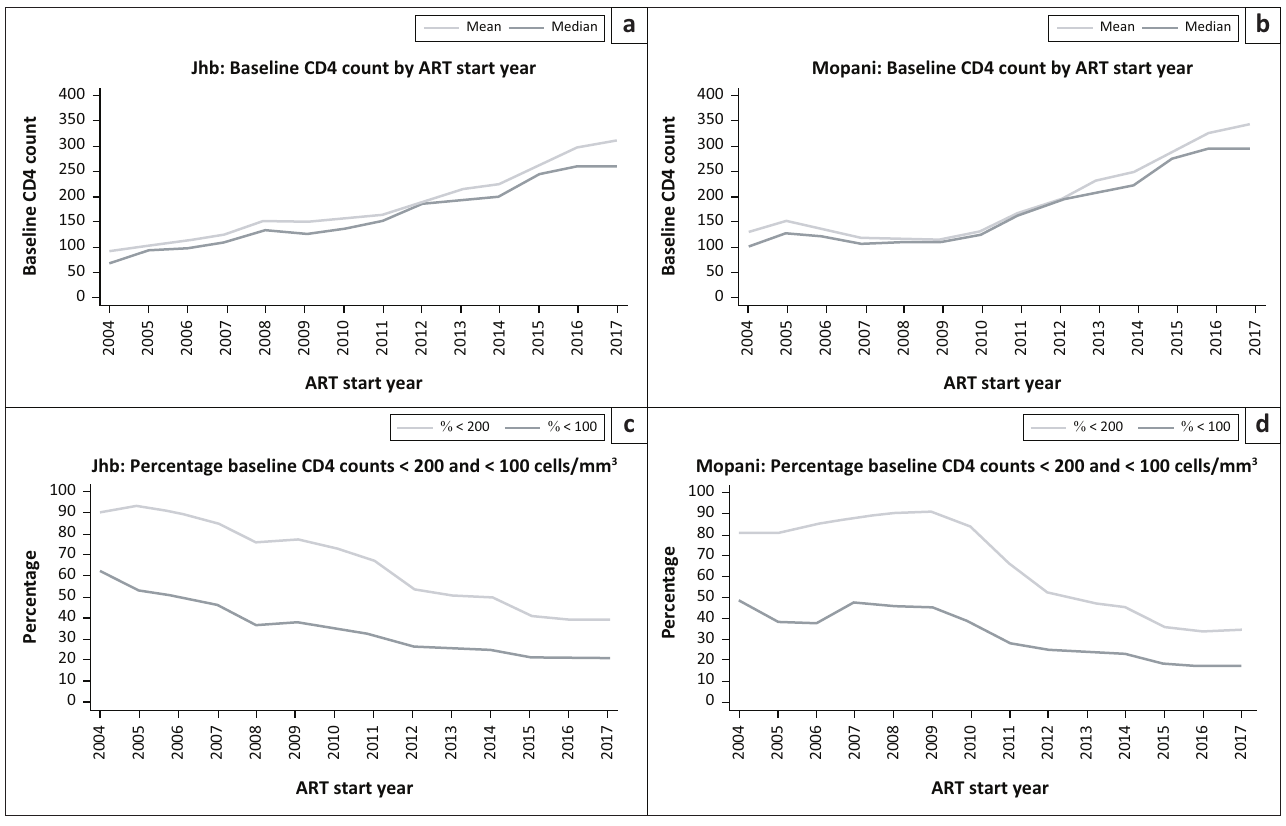
FIGURE 2: Mean and median baseline CD4 count over time and percentage baseline CD4 counts < 200 and < 100 cells/mm 3 in Johannesburg district (a and c) and Mopani district (b and